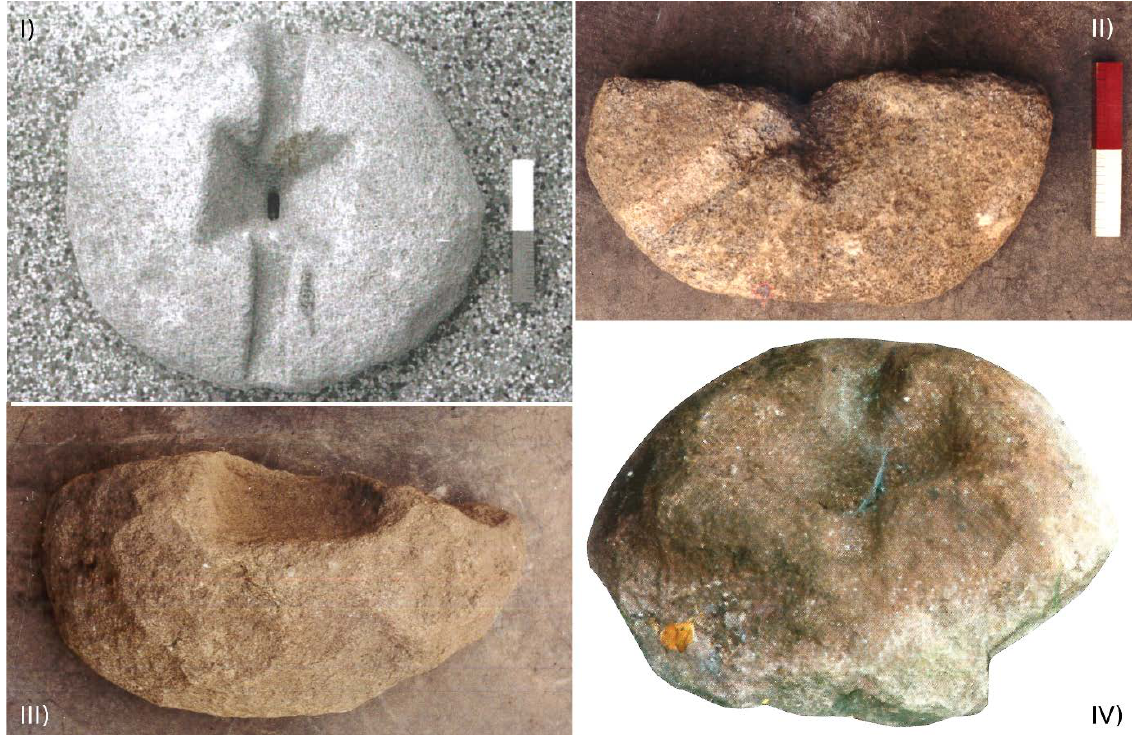
Figure 8. The other Olynthus mills from the Piave and Brenta valleys. I) Oderzo (after Donner 1992); II-III) Castelciés (after Donner 1992); IV Castle of Pergine (after Pasquali 2010: